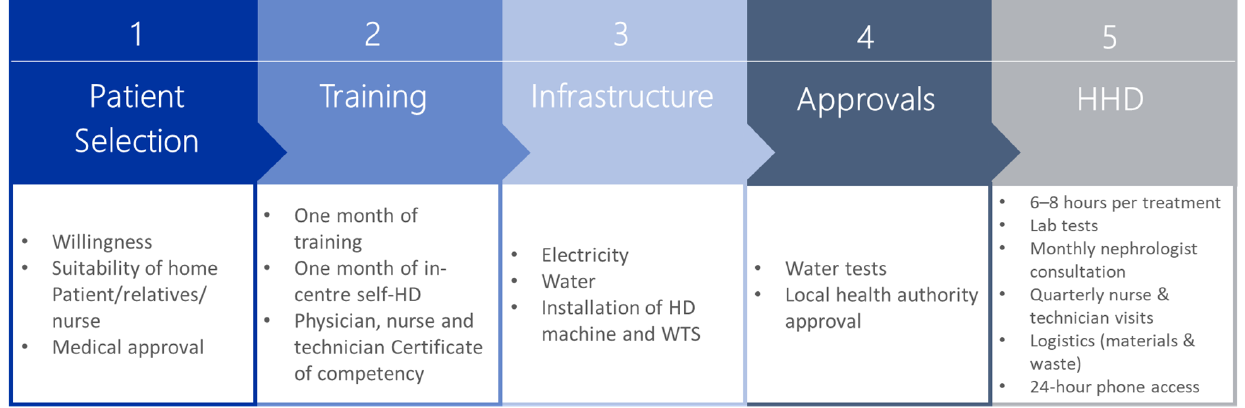
Figure 2. Steps in the HHD pathway. Abbreviations: HD, haemodialysis; HHD, home haemodialysis; WTS, water treatment system.